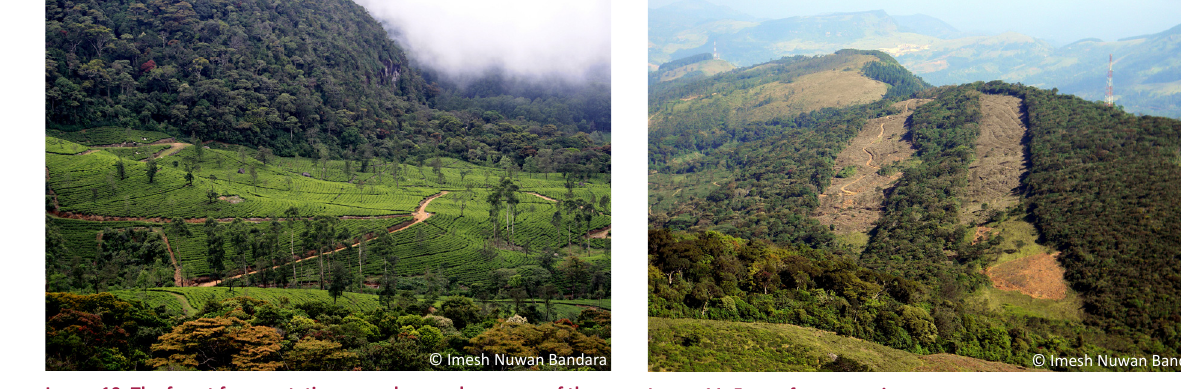
Image 11. Forest